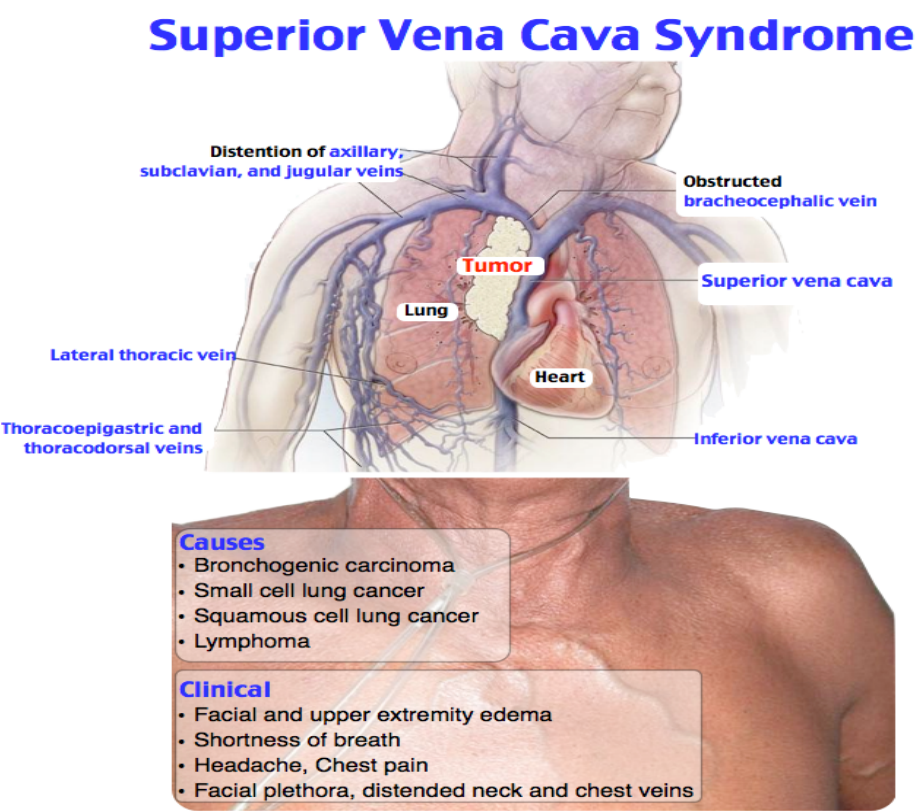
Figure 1. The syndrome was originally described as being secondary to an infection such as tuberculosis or a syphilitic aortic aneurysm [1–3]. Currently, superior vena cava syndrome is generally due to cancer or thrombotic events. Table 1. Common causes of superior vena cava syndrome.